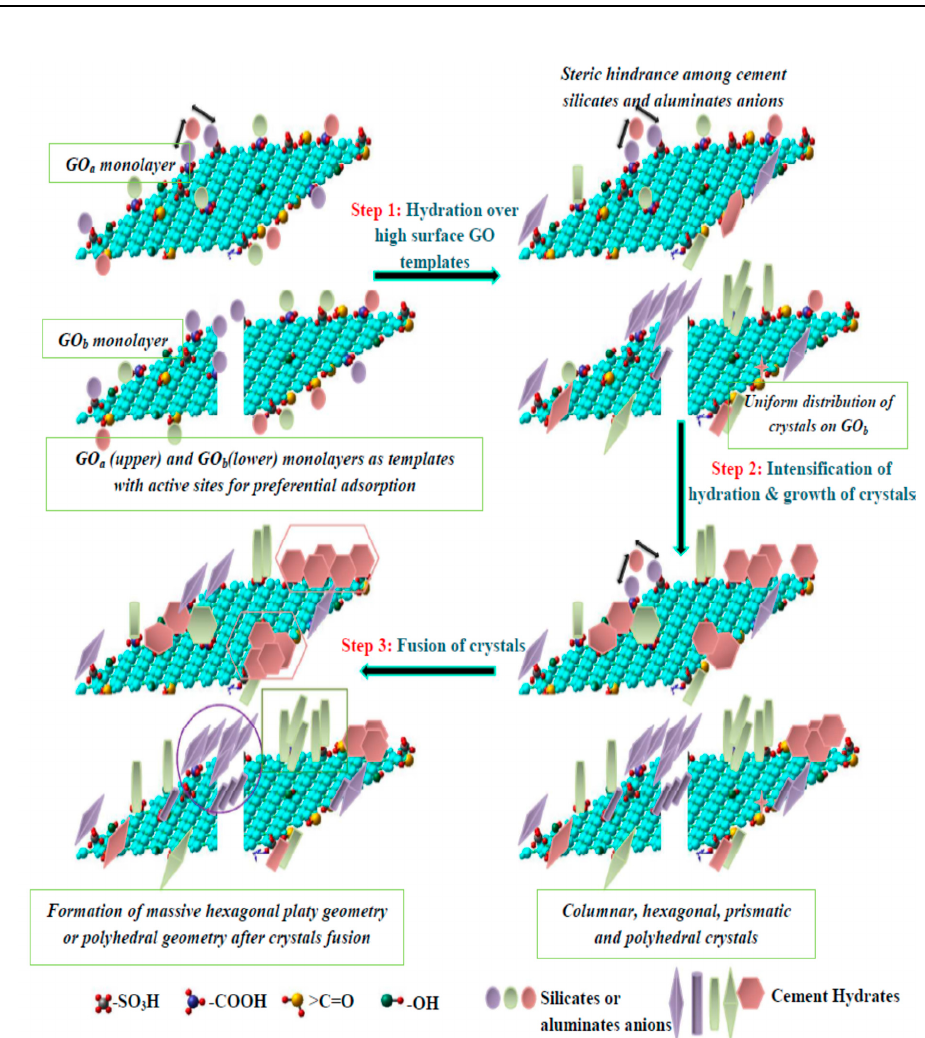
Figure 22. Schematic diagram of growing cement hydrates on templates of GO monolayers. Reproduced with permission from [138], RSC Advances,